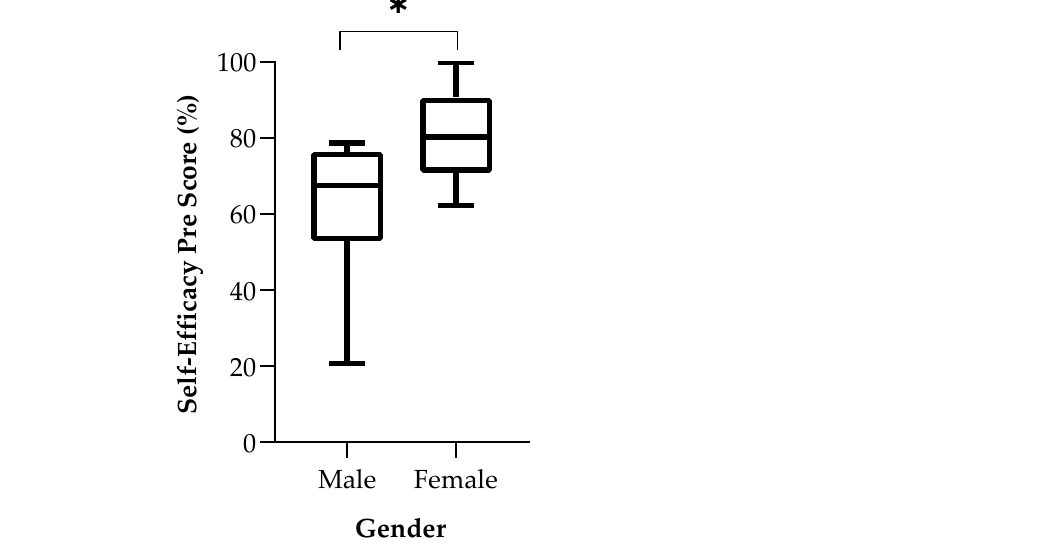
Figure 2. Box Plot comparing baseline Self-Efficacy Scores between males and females who completed both surveys. * Indicates statistically significant mean differences ( α = 0.05) using Welch’s t -tests. Table 2. Male and Female Pre-study and Post-study Survey Score Comparisons for all Four Scales.